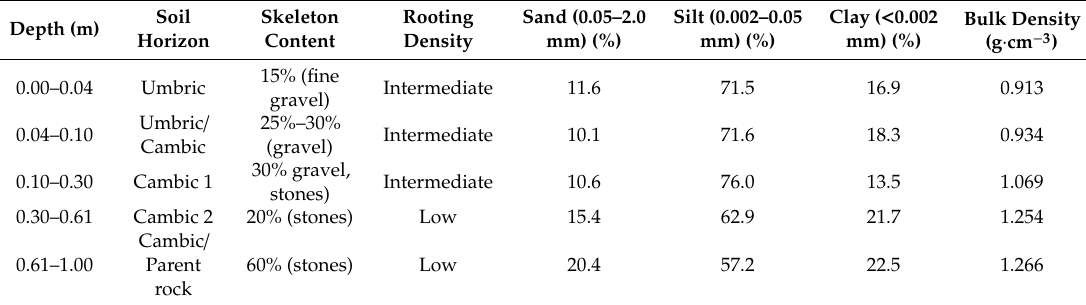
Table 1. Physical and chemical properties of the soil on the study